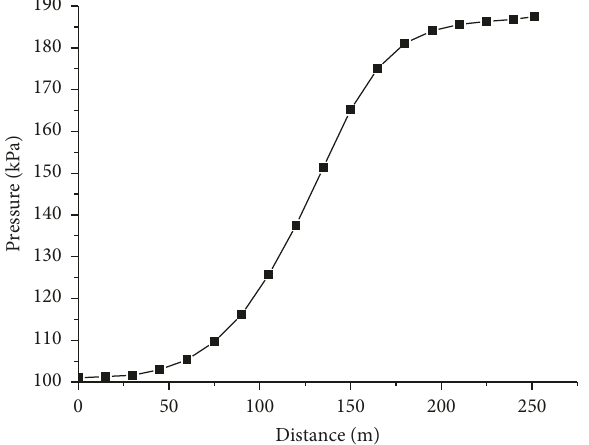
Figure 11: Pressure below sacked gangue.